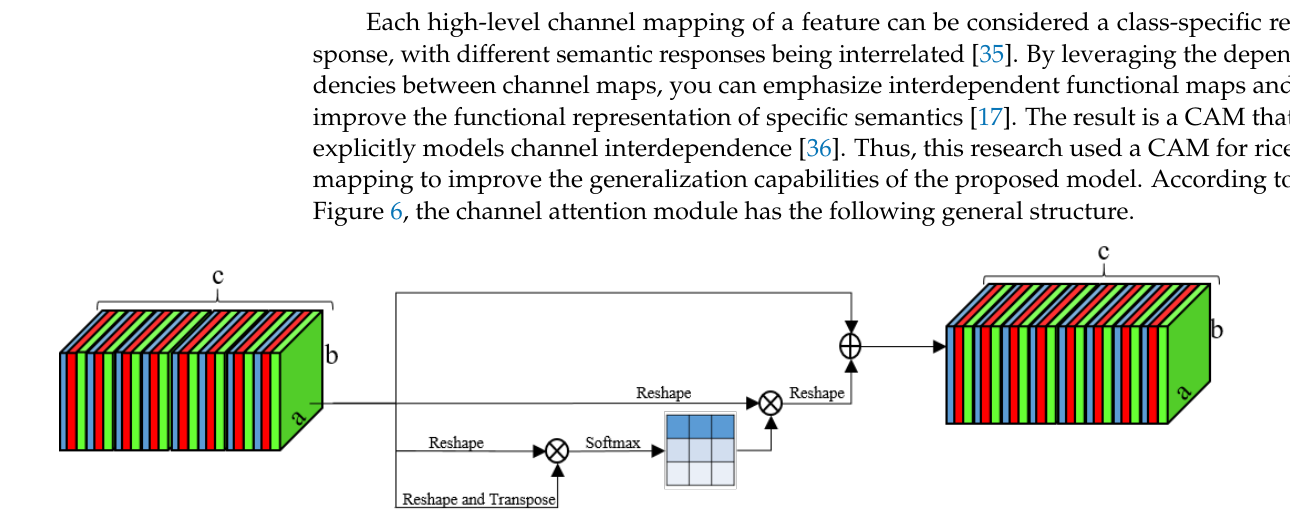
Figure 6. The general structure of CAM.